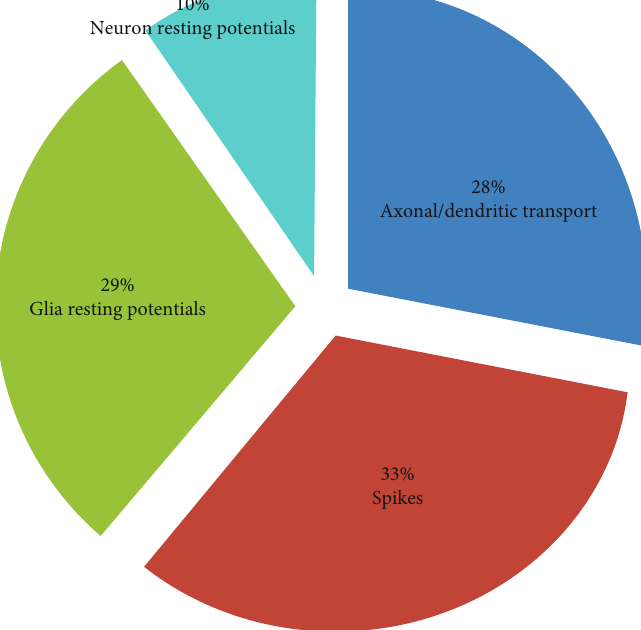
Figure 3: Distribution of energy consumption in neural networks.